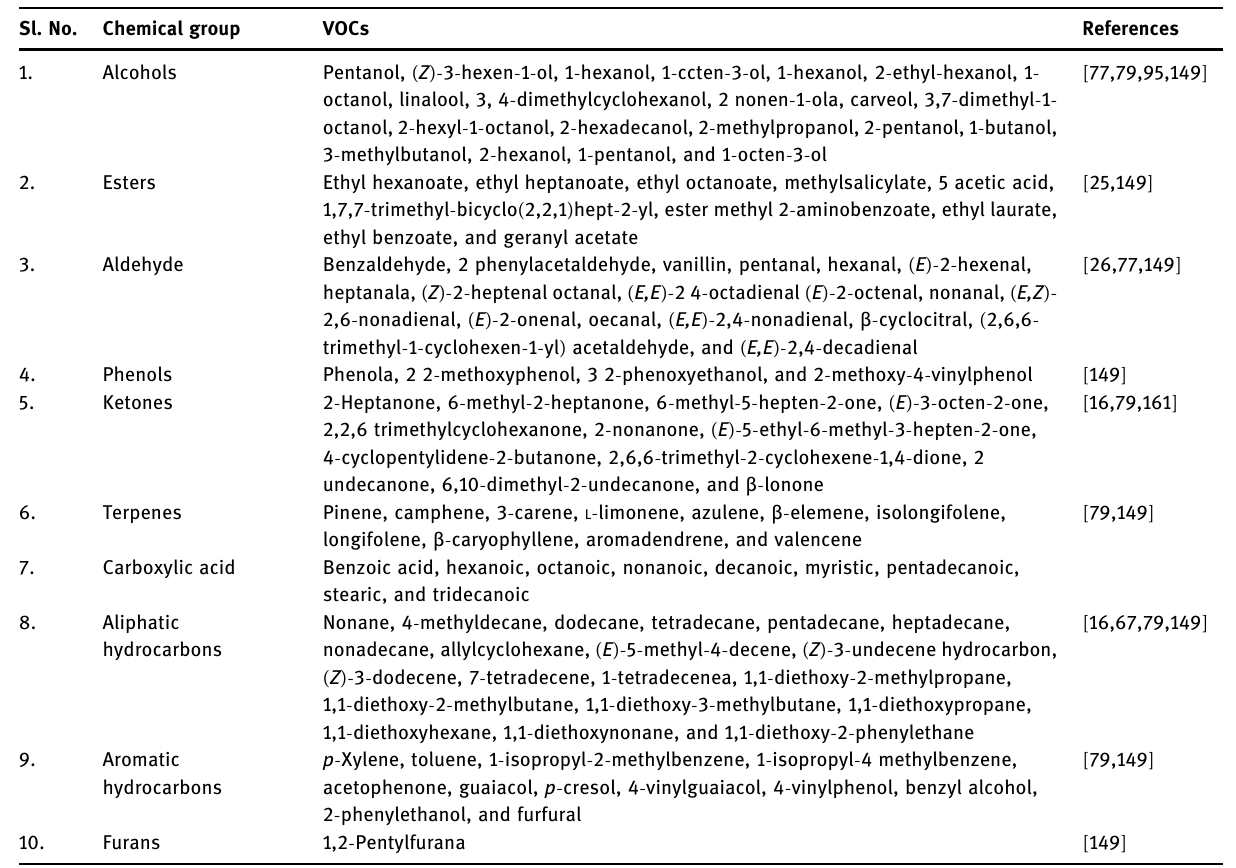
Table 2: Chemical characterization of VACs of Asiatic aromatic rice Sl. No. Chemical